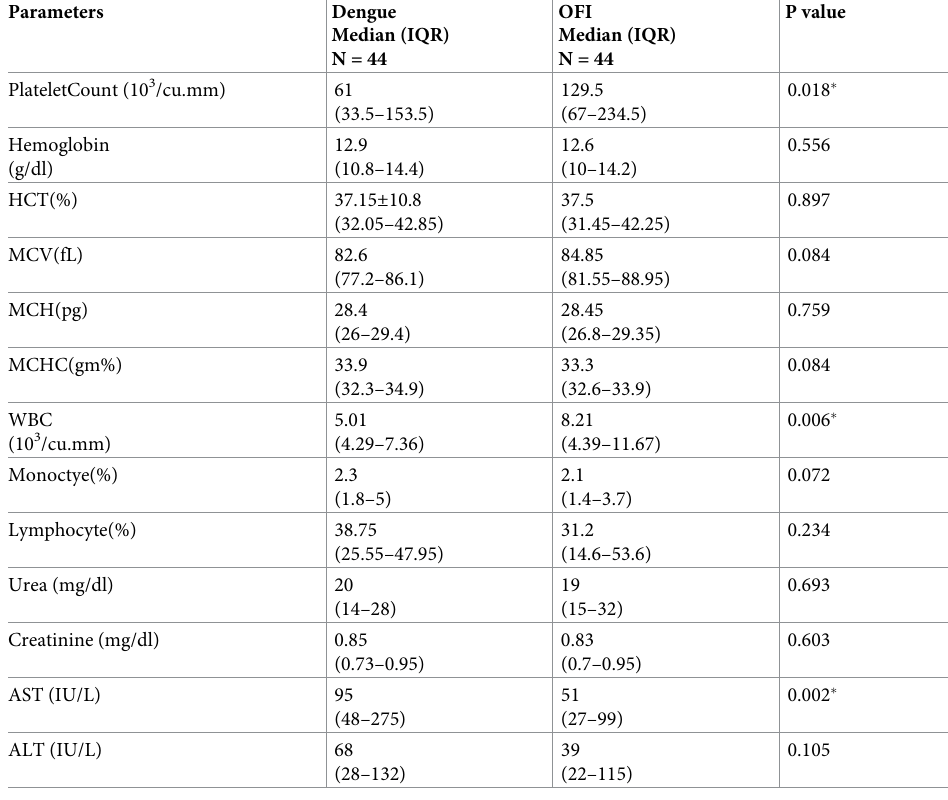
Table 1. Comparison of hematological and biochemical parameters in dengue and other febrile illness during admission.